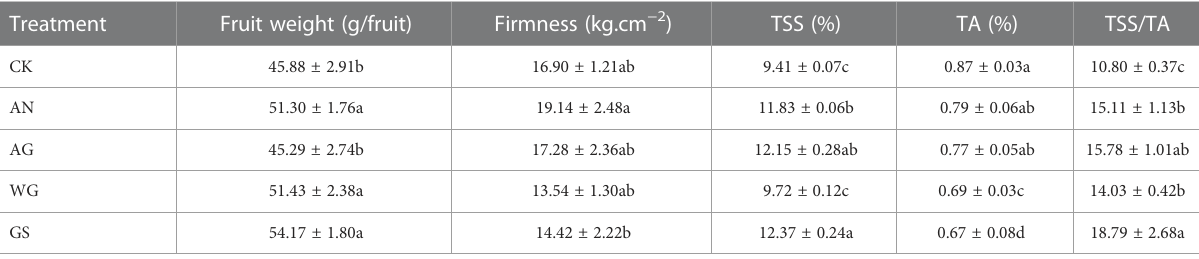
TABLE 1 Effects of biostimulants on the fruit appearance quality.